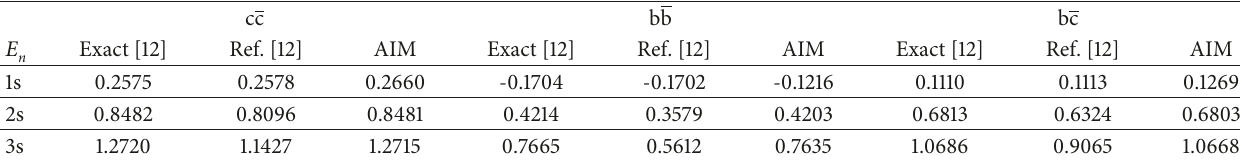
Table 6: Comparisons of the energy eigenvalues (in GeV) of the mesons cc, bb, and bc calculated by using (28) with the exact ones of [12]. The parameters of Cornell potential are 𝐴 = 0.52 and 𝐵 = 0.43 GeV, while the quark masses are 𝑚 𝑐 =1.84 GeV and 𝑚 𝑏 =5.18 GeV. cc bb bc